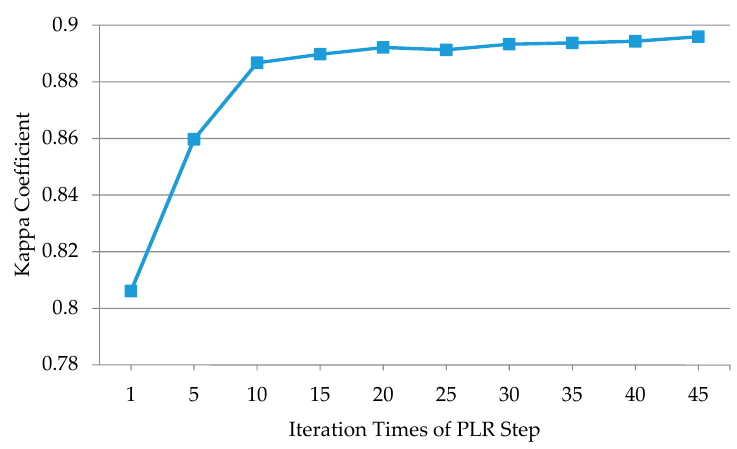
Figure 15. Kappa coefficients of applying SP-KSEM-PLR to the RADARSAT-2 image with different PLR step iteration times.